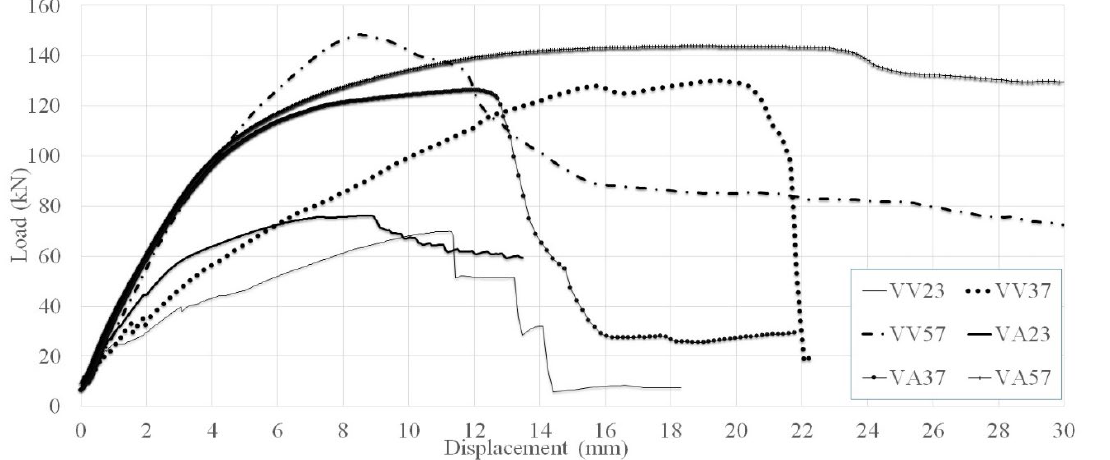
Figure 15. Load vs displacement curves for all